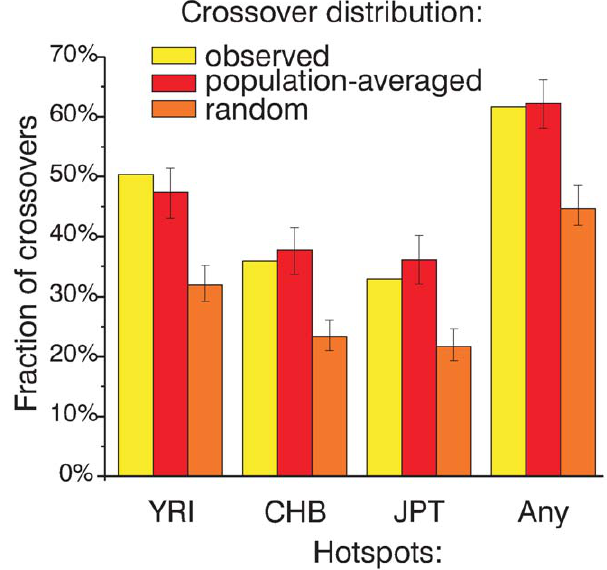
Figure 5. Most CEPH crossovers not predicted by CEU hotspots overlap hotspots from other populations. The fraction of crossover intervals not predicted by CEU hotspots that overlap hotspots found in YRI, CHB, JPT, or any of the other HapMap PhaseII populations (YRI, CHB, or JPT) is plotted. For comparison, the same fraction of crossovers overlapping hotspots from other populations (mean and 95% CI) is plotted for crossovers re-distributed according to the population-averaged map and randomly distributed